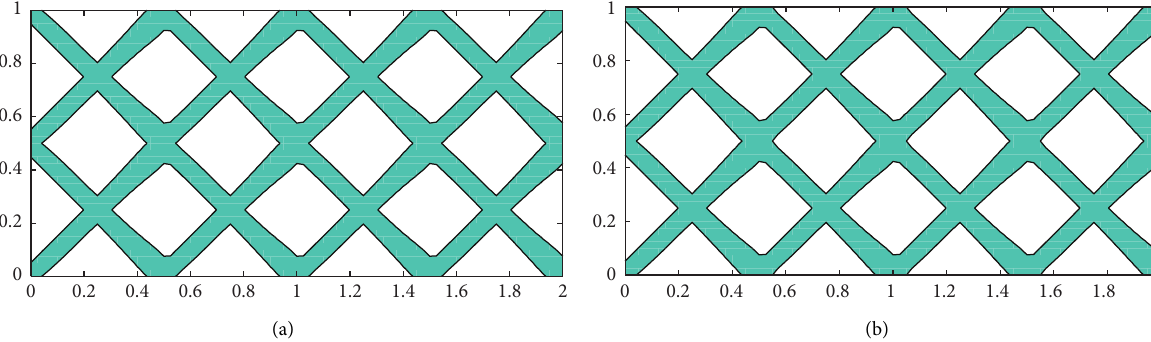
Figure 8: The initial designs for the compliant mechanism problem: (a) QVT and (b) the paper method.